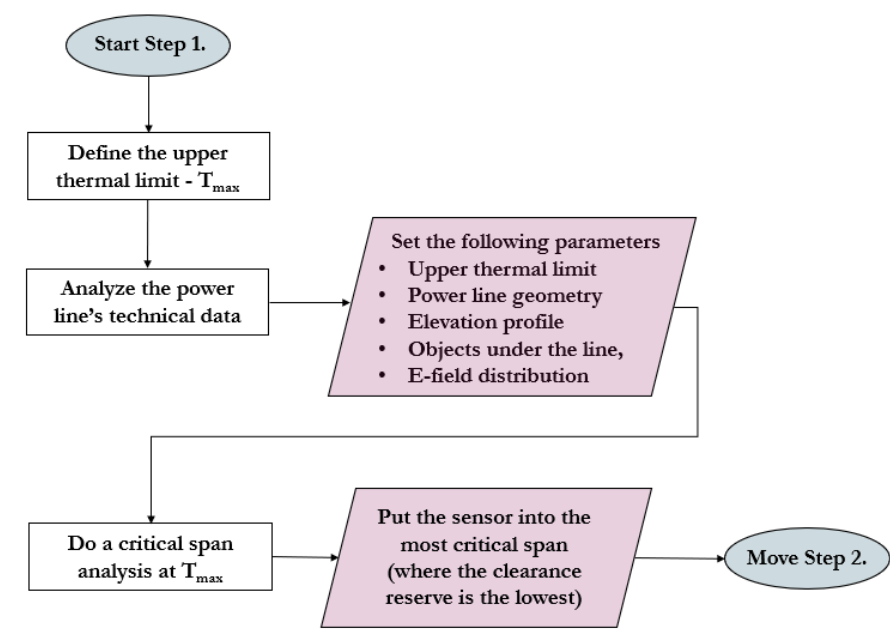
Figure 2. Flowchart of Step 1 in the novel sensor placement protocol based on Figure 2. . Flowchart of Step 1 in the novel sensor placement protocol based on [16].